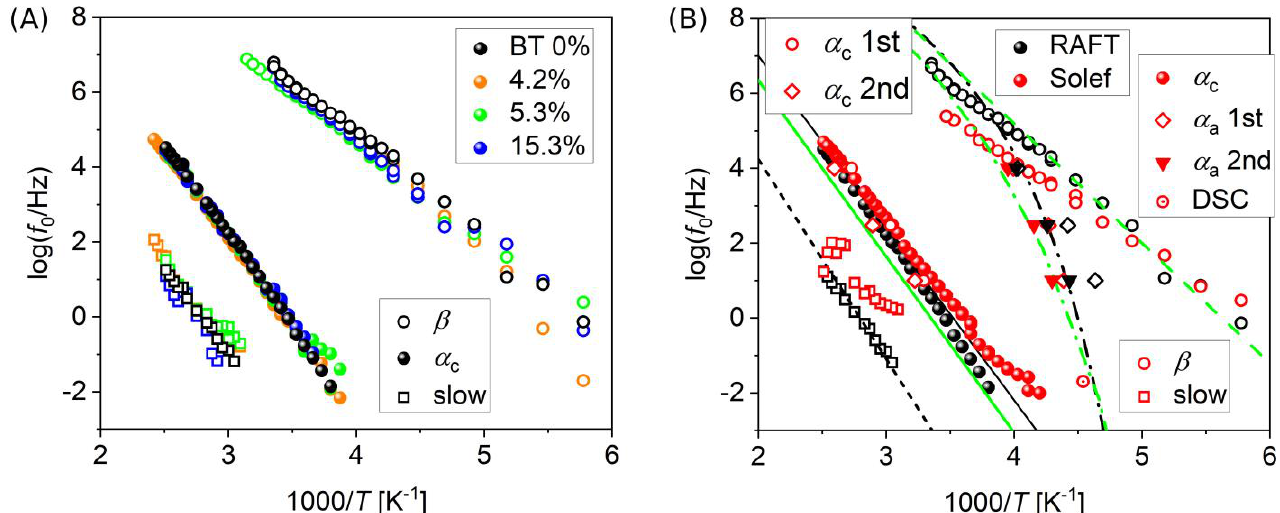
Figure 4. Relaxation plots for different PVDF samples, resulting from fitting of dielectric loss spectra. ( A ) Comparison among nanocomposites with different BT contents. ( B ) Comparison between PVDF obtained by RAFT polymerization (RAFT, black symbols) and commercial, high molar mass PVDF (Solef, red symbols). Lines indicate literature data from two different studies (black lines from Ref. [45] and green lines from Ref. [56]), for all the reported processes: dashed line for the β process, dash-dot lines for the α a process, solid lines for the α c process, dotted line for the “interfacial” process of Ref. [ 45] (corresponding to our slow process). Three points derived from our BDS isochronal spectra (as the ones shown in Figure 5 below) are also reported for both materials, pertaining to both the α a and the α c processes, on the 1st heating ( α a , α c 1st), as well as on the 2nd heating ( α a , α c 2nd), after cooling with the same rate of 10 °C/min. One point corresponding to the calorimetric glass transition temperature derived from DSC thermograms for Solef PVDF (shown in Figure 6D below) is also reported.